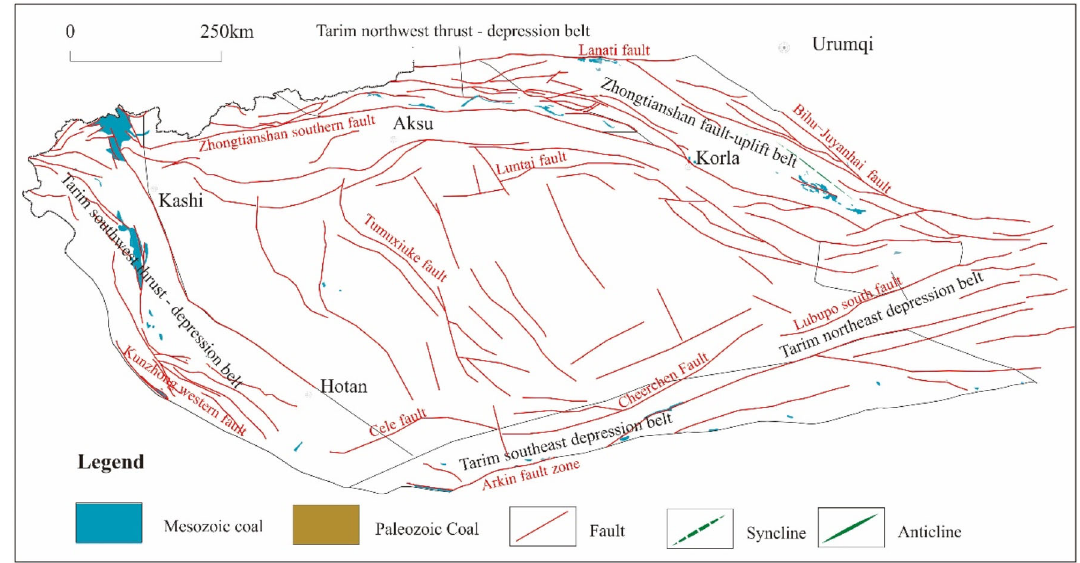
Fig. 13 Diagram of the structural outline in the Tarim Basin coal occurrence structural